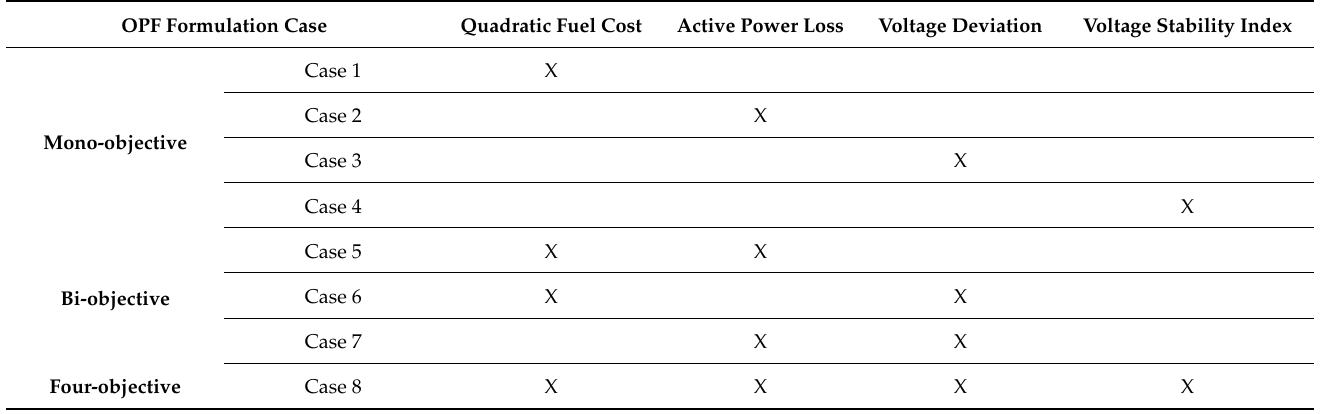
Table 3. Summary of various OPF